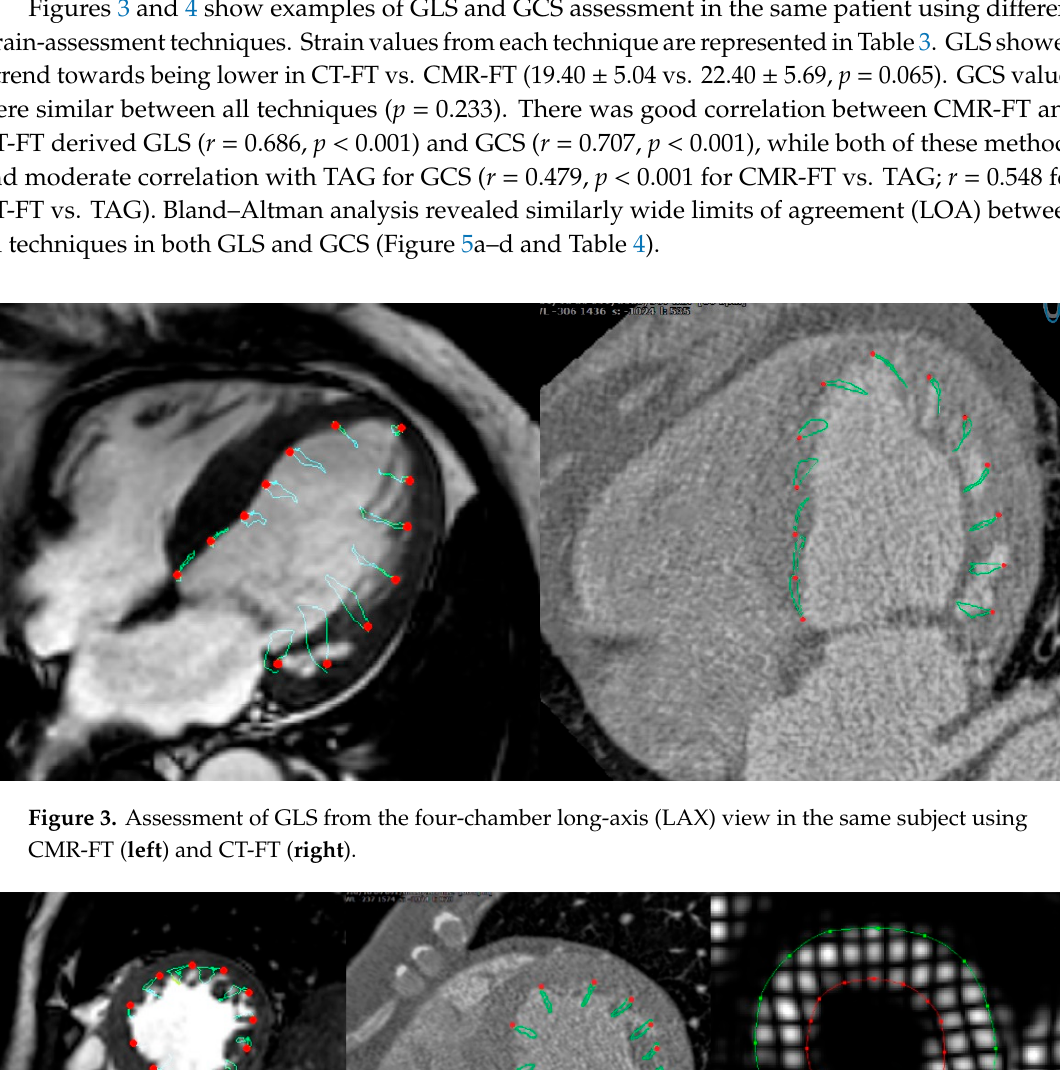
Table 4. Tabular representation of Bland–Altman and Pearson’s correlation analyses for strain assessment.